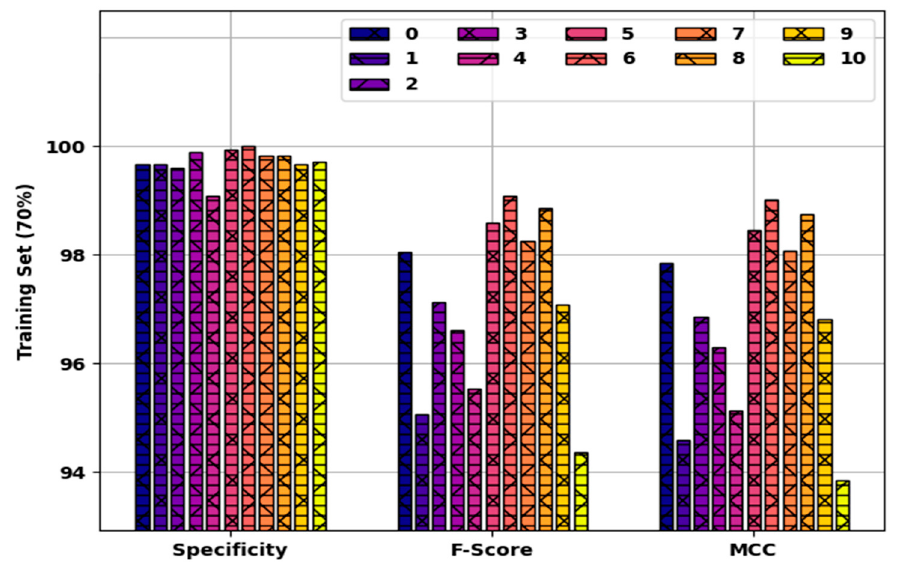
Figure 5. Acc y , Prec n , and reca l analysis of SFODLD-SAC technique on 70% of TRS for classes 0–10. Figure 5. 𝐴𝑐𝑐 (cid:3052) , 𝑃𝑟𝑒𝑐 (cid:3041) , and 𝑟𝑒𝑐𝑎 (cid:3039) analysis of SFODLD-SAC technique on 70% of TRS for classes 0–10.